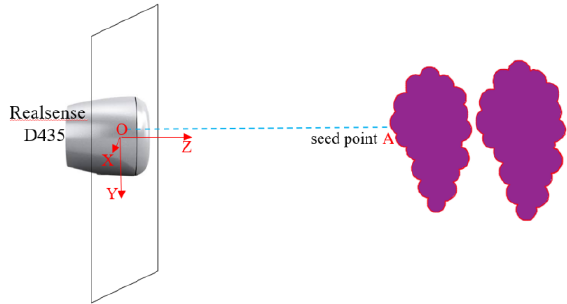
Figure 10. The selection of the seed point.